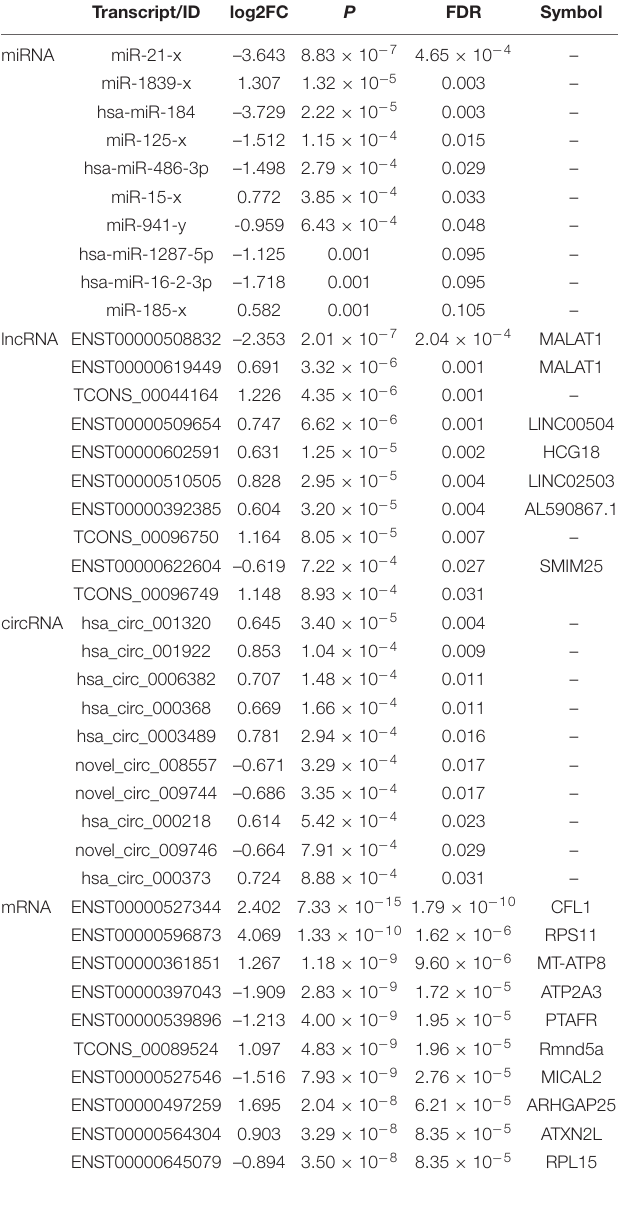
TABLE 3 | Top 10 differential miRNAs, circRNAs, lncRNAs, and mRNAs between MDD and